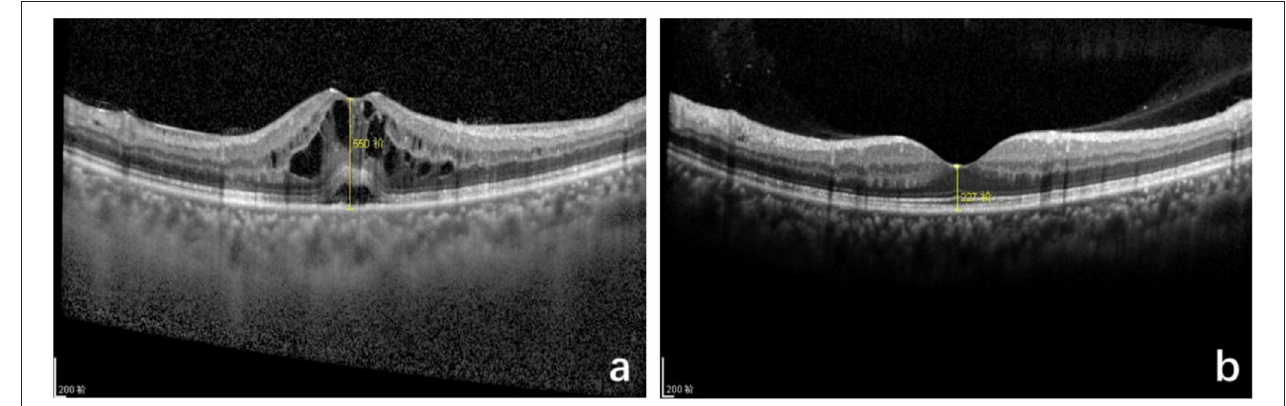
FIGURE 2 | Optical coherence tomography (OCT) macular image before and after intravitreal TA treatment of pseudophakic cystoid macular edema (PCME). (a) Before injection, cystoid macular edema, central macular thickness (CMT): 550 µ m. (b) Six months after injection, standard macular structure, CMT: 227 µ